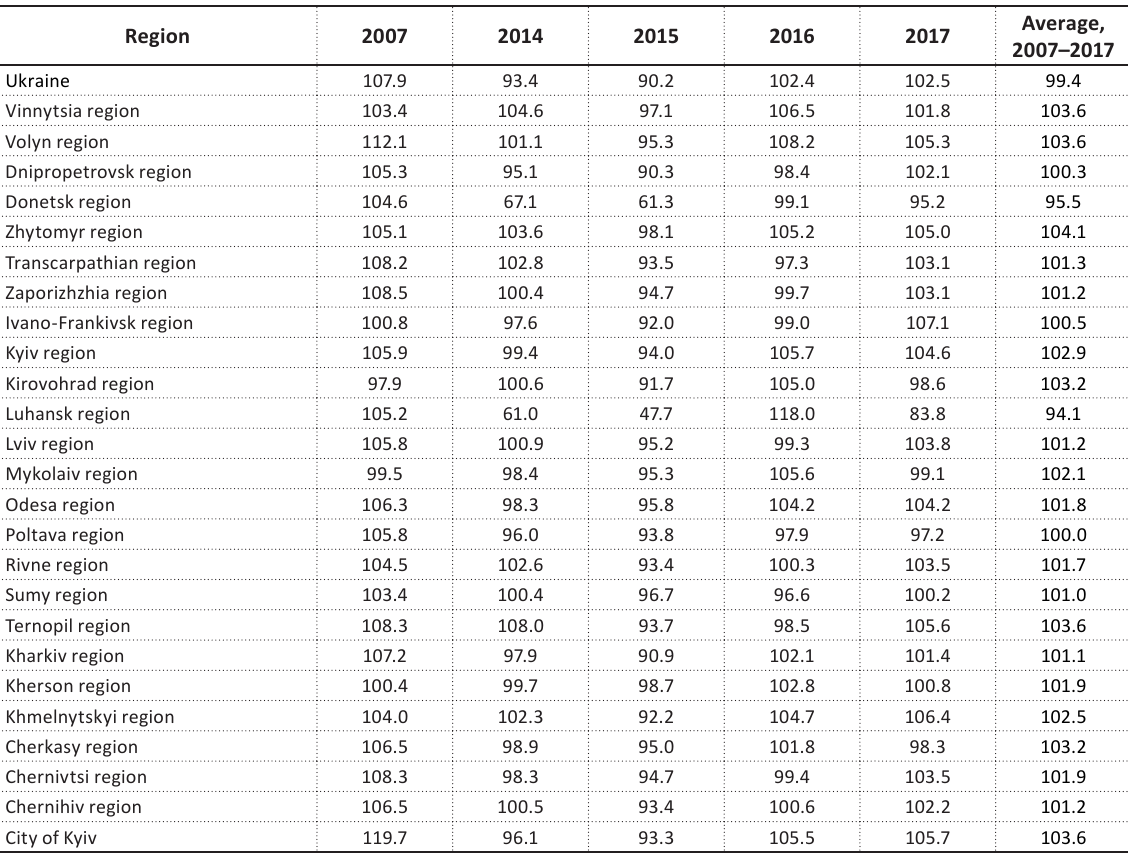
Table 1. Dynamics of indices of physical volume of gross regional product (in the prices of the previous year, percentage)